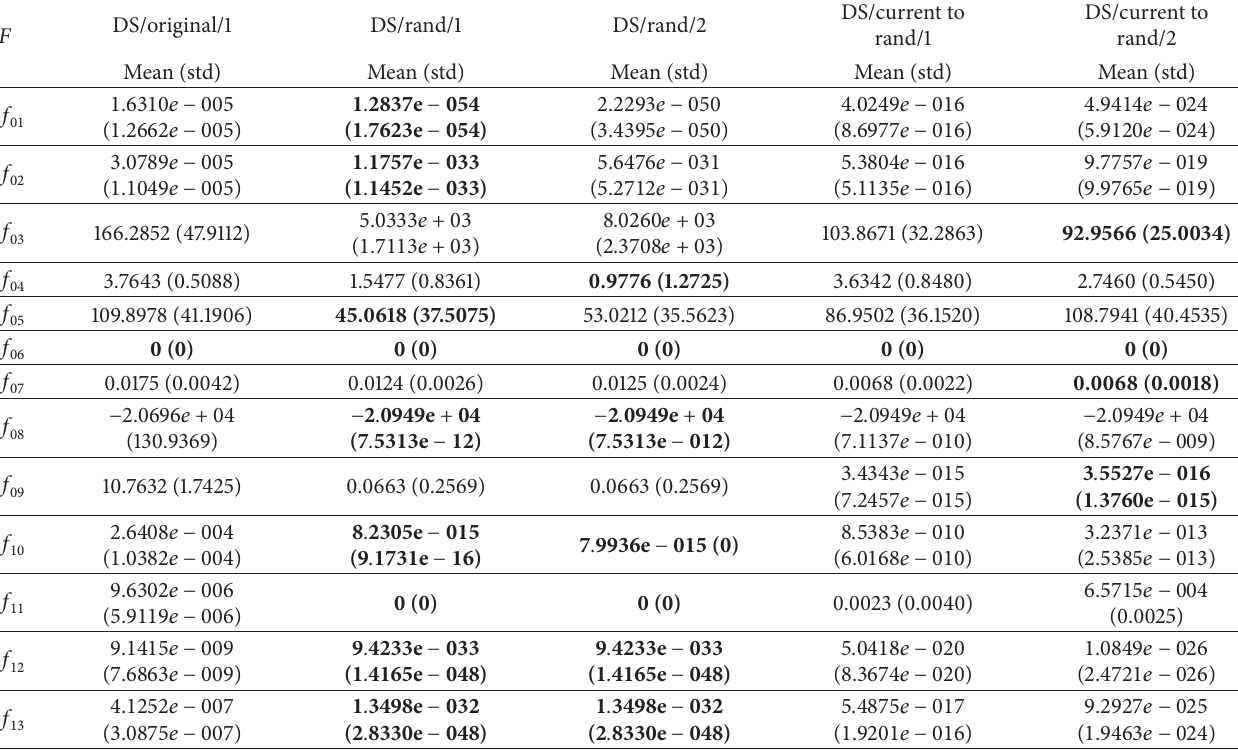
Table 5: Comparisons of different schemes for 50 𝐷 .